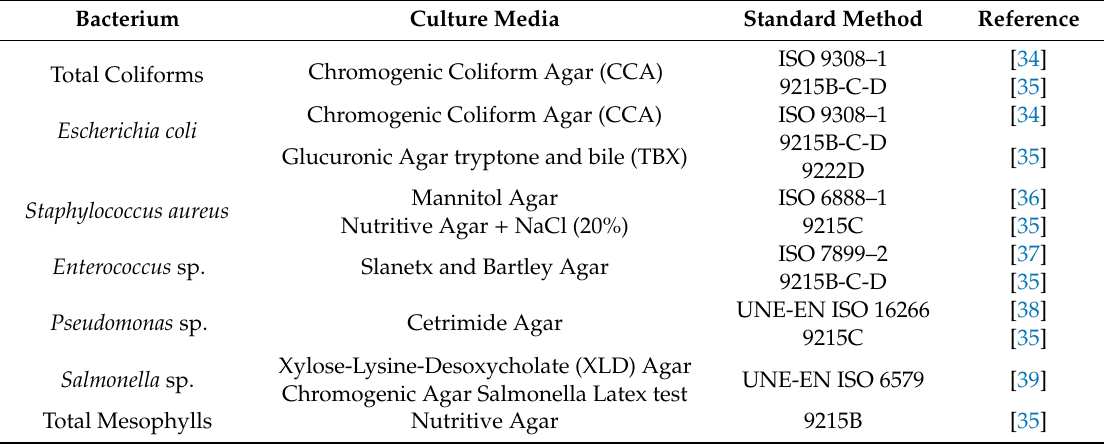
Table 2. Microbiological parameters, culture media and standard